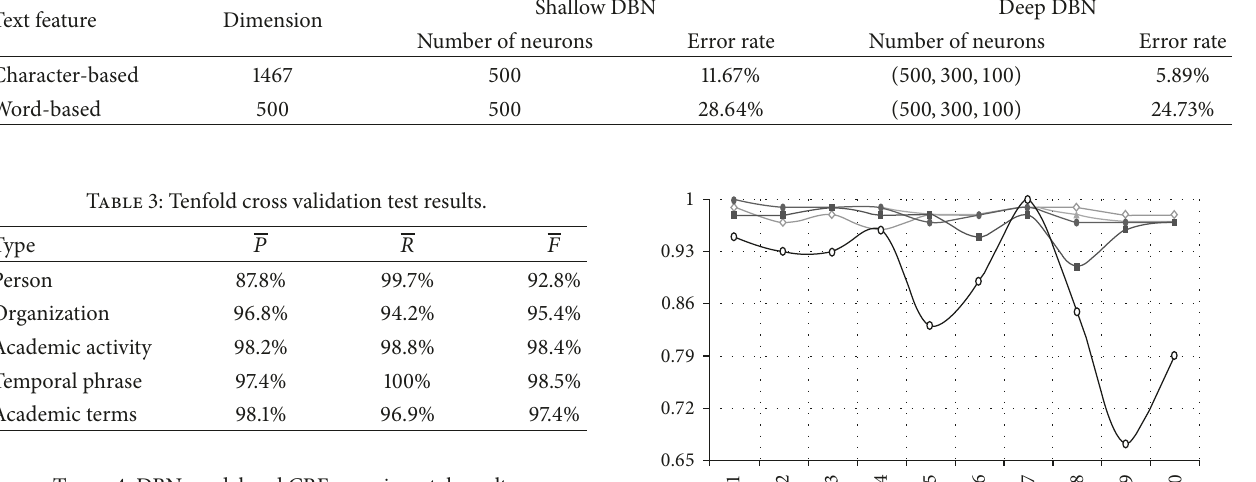
Table 4: DBN model and CRF experimental results.